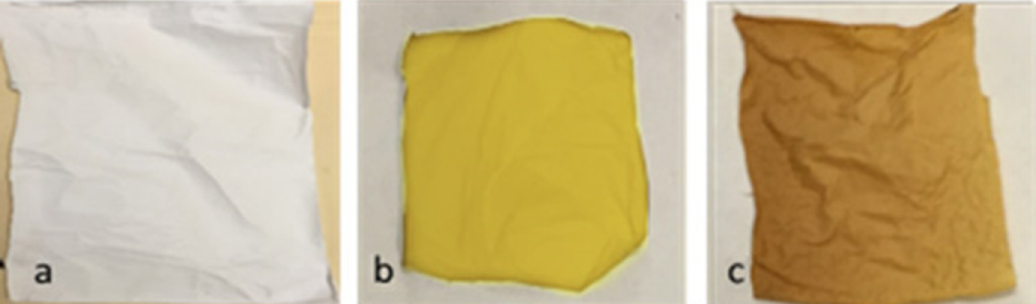
Figure 1. Optical images of 16% electrospun PAN composite nanofiber mat heated to different temperatures in air: ( a ) as spun; ( b ) annealed at 130 °C for 1 h; ( c ) annealed at 180 °C for 1 h.